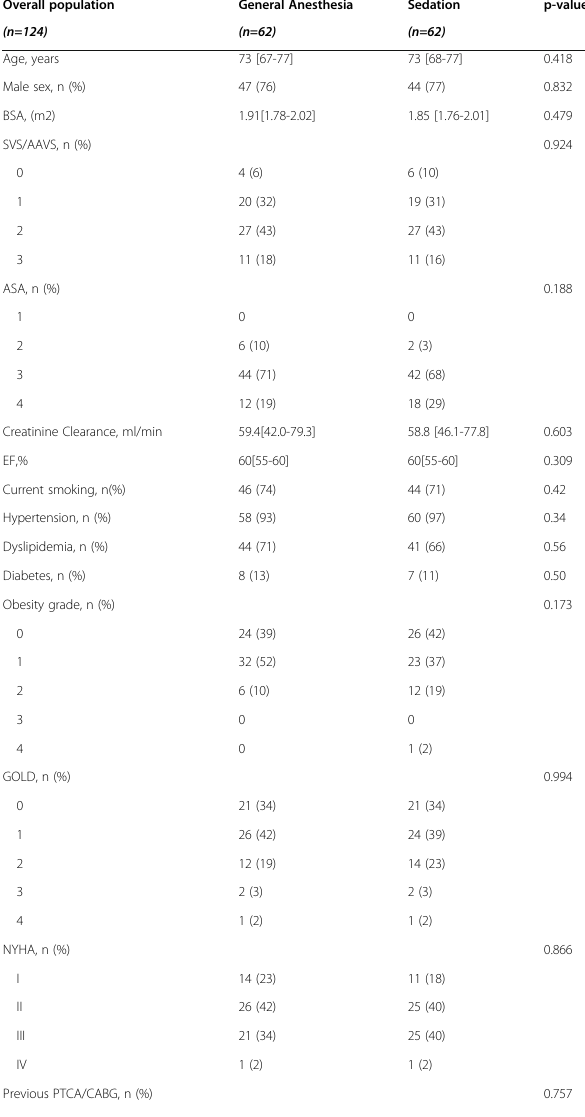
Table 1 (abstract A73). Baseline clinical